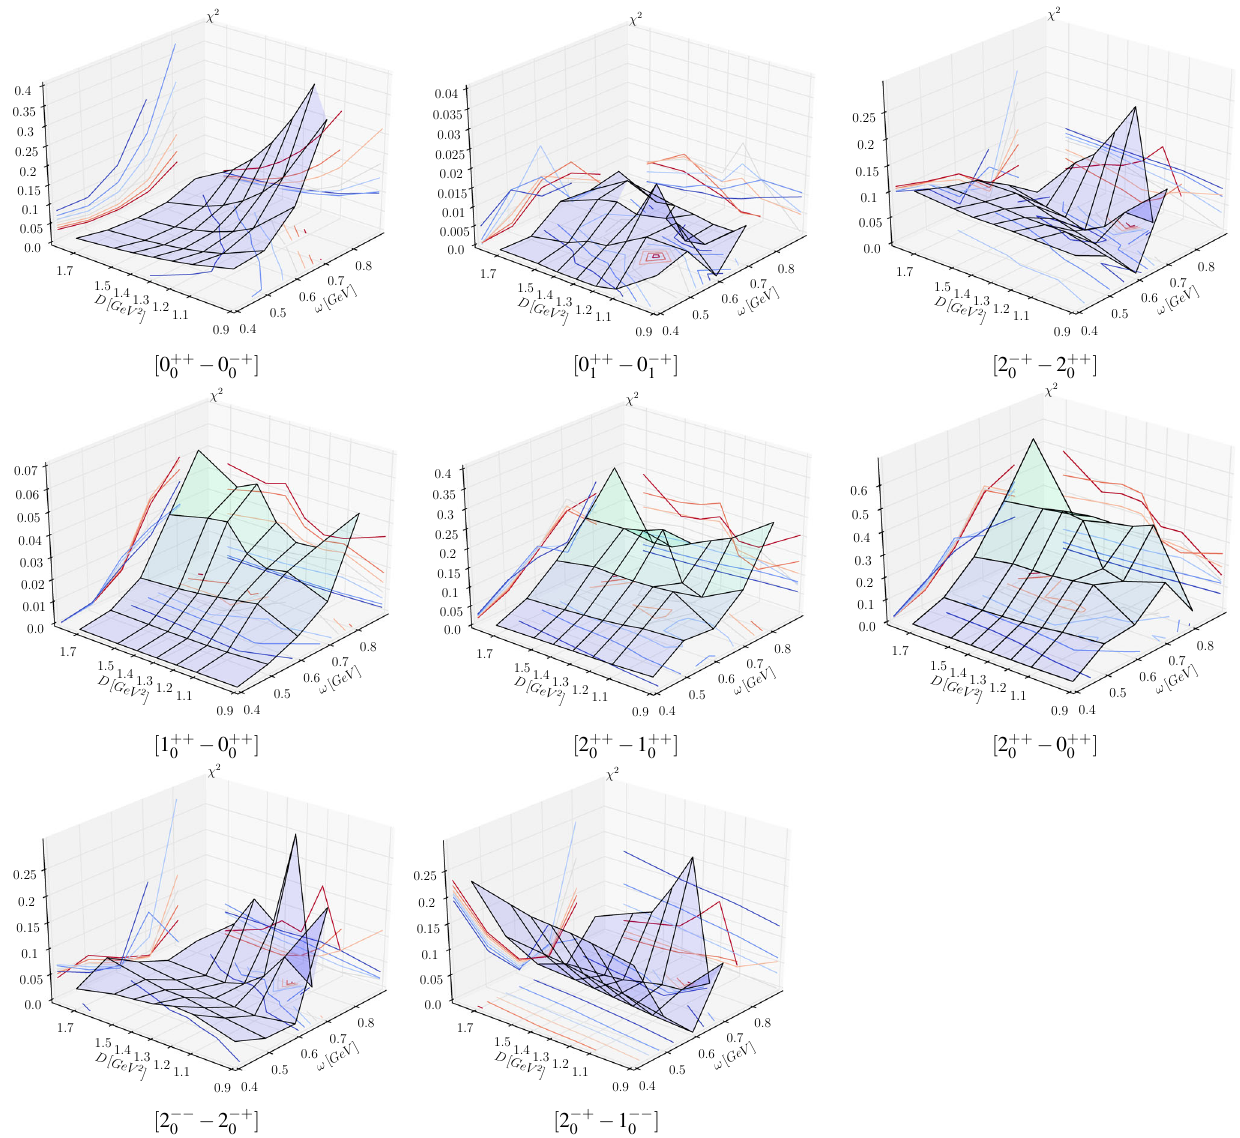
Fig. 20 χ 2 plot from the comparison of our calculated and the experimental other splitting as a function of ω and D